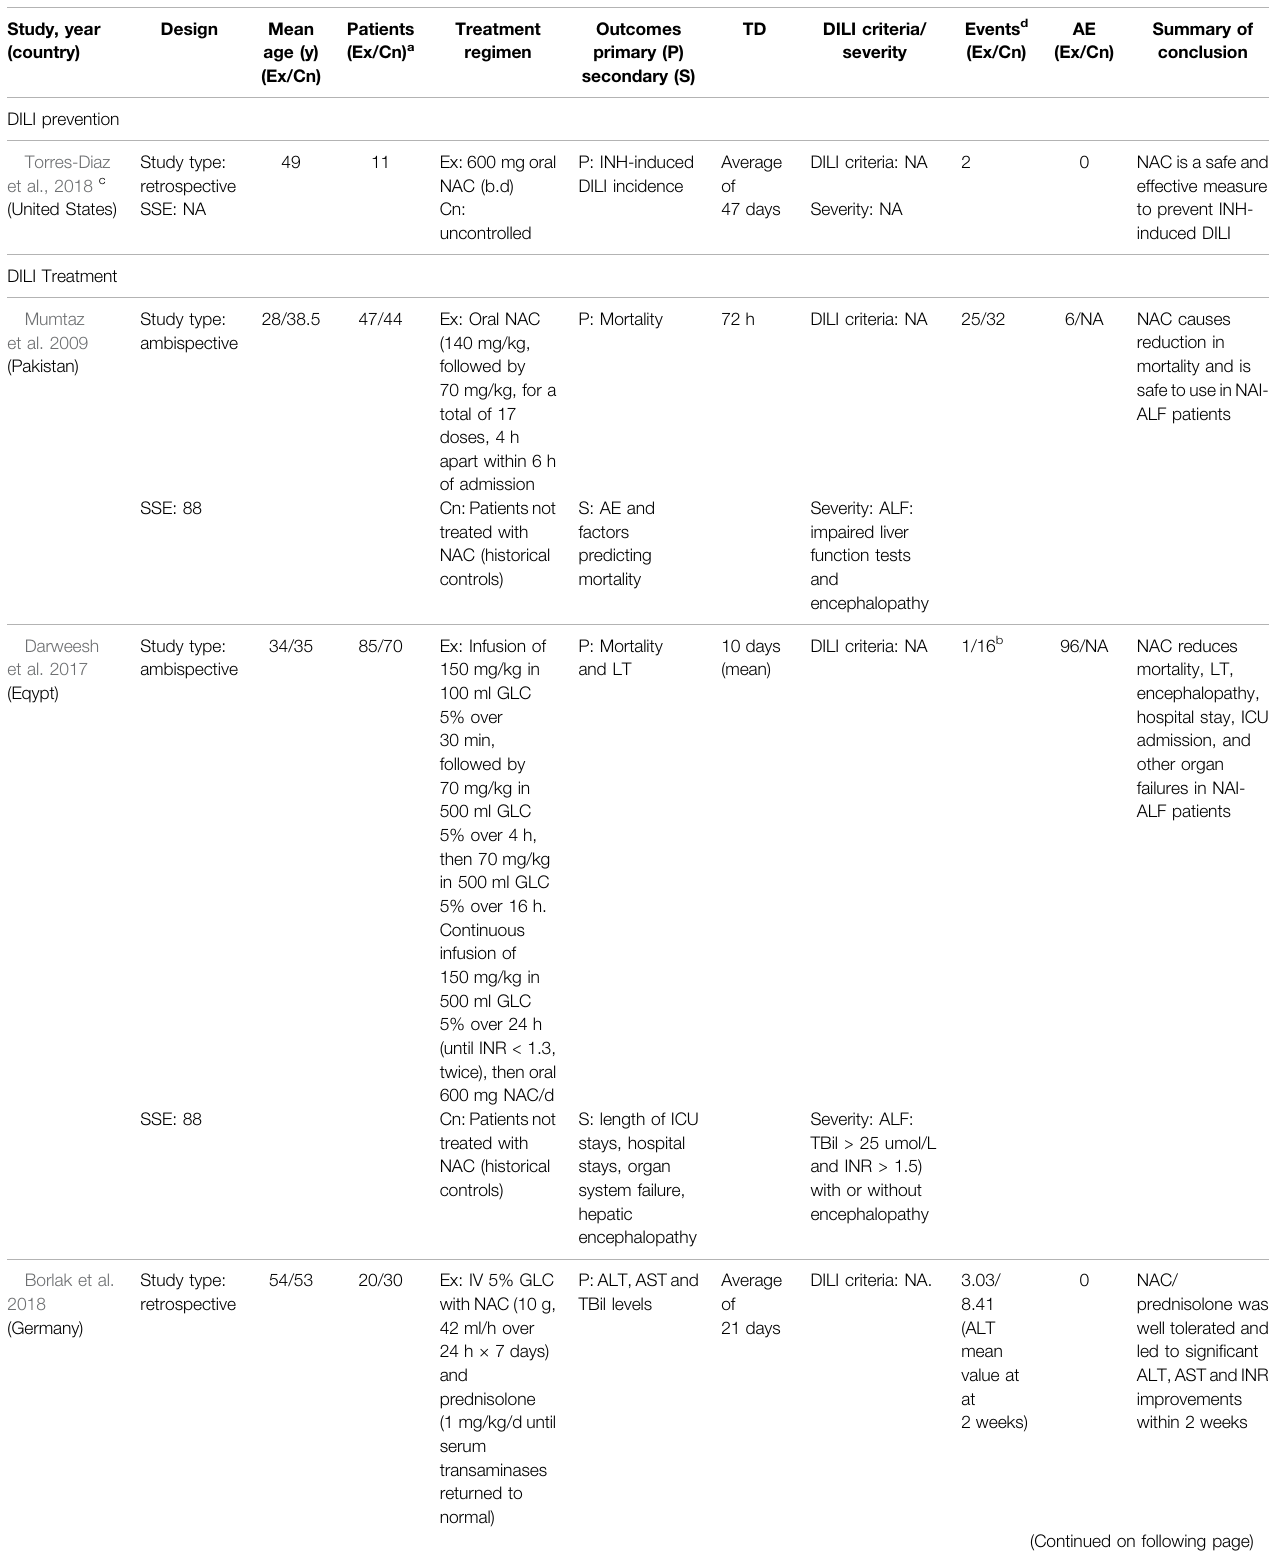
TABLE 2 | Characteristics of observational studies included in the systematic